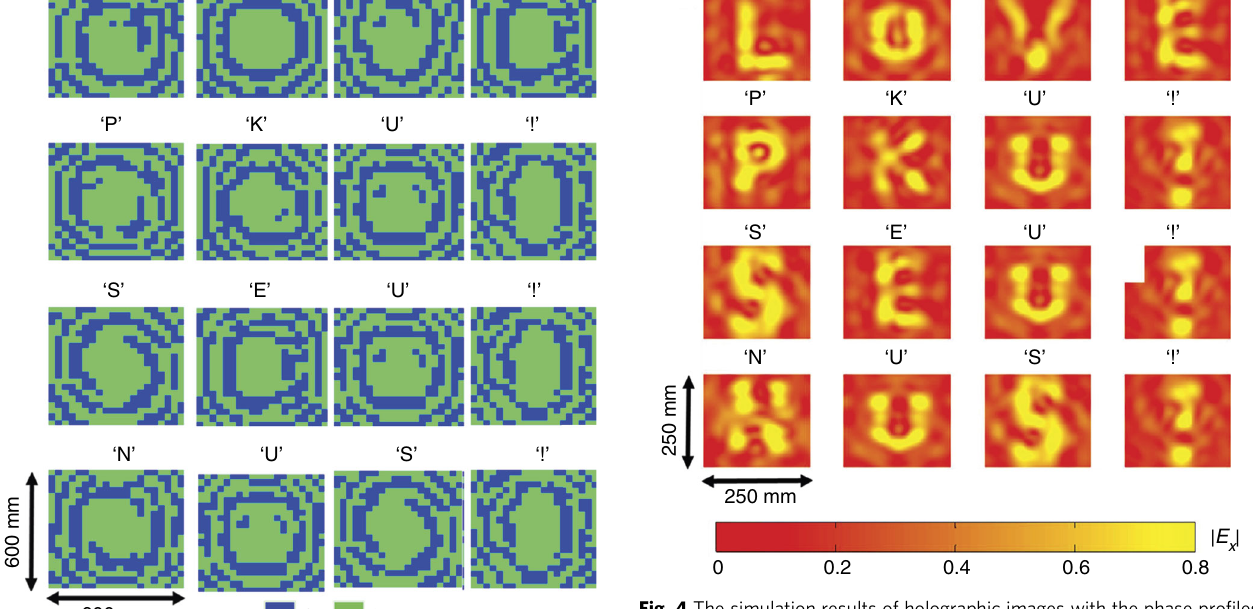
Fig. 4 The simulation results of holographic images with the phase pro fi les in Fig. 3. The simulated holographic images ( E x - fi eld intensity) of ‘ LOVE PKU! SEU! NUS! ’ corresponding to the holograms shown in Fig. 3 are obtained at the image plane of Z r = 0.4 m with an x -polarized incidence ‘L’